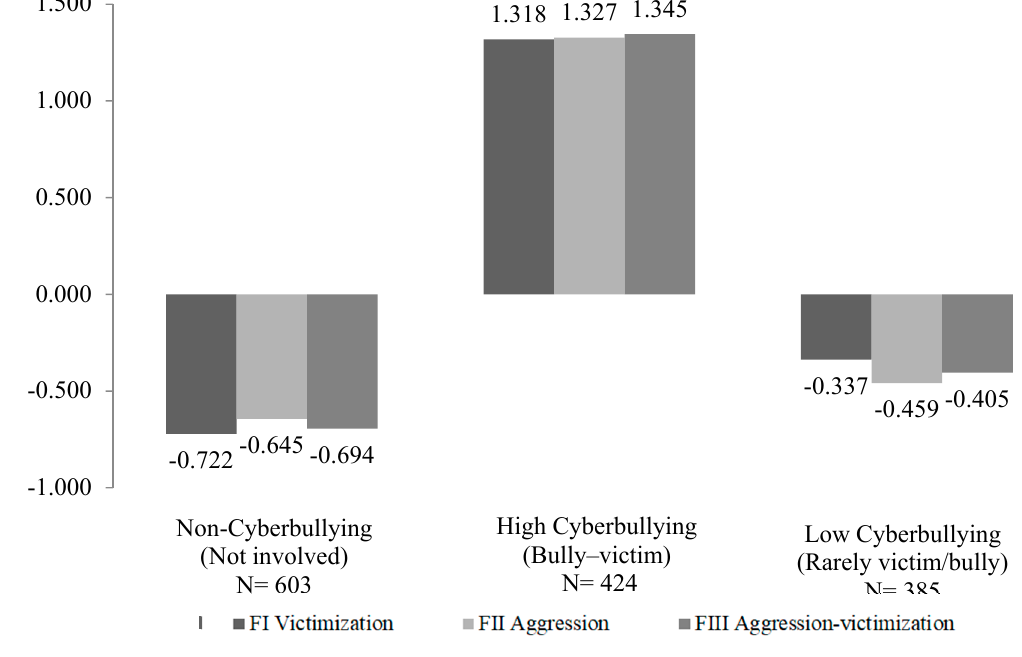
Figure 1. Graphic representation of the LCA solution.